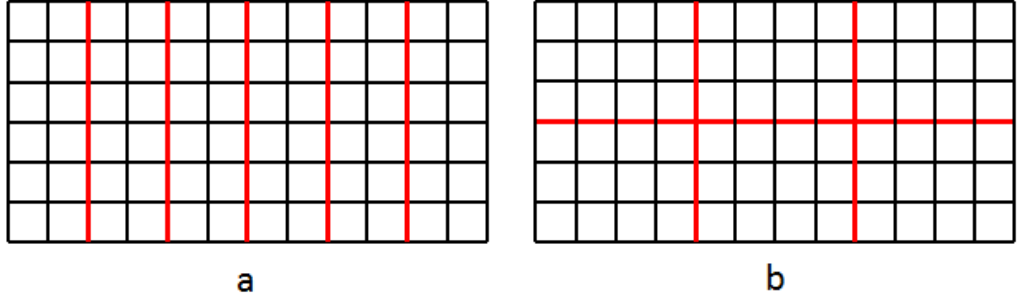
Figure 3. Data partitioning methods: ( a ) one-dimensional (1D) partitioning; ( b ) two-dimensional (2D) partitioning.